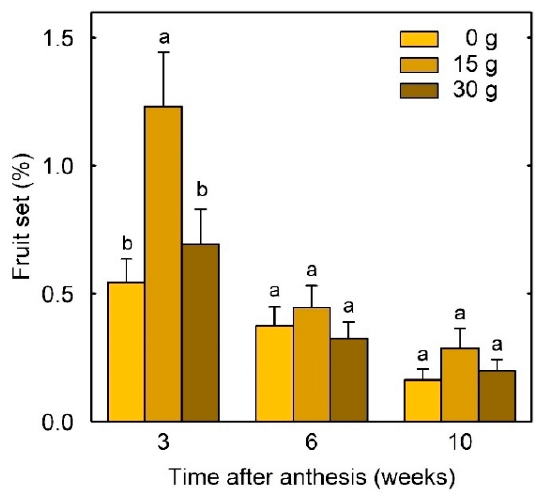
Figure 2. Fruit set on racemes of macadamia cultivar ‘816’ trees treated with 0, 15 or 30 g B prior to flowering. Means (+SE) with different letters within a time point are significantly different (generalised linear models, p < 0.05, n = 50 racemes).